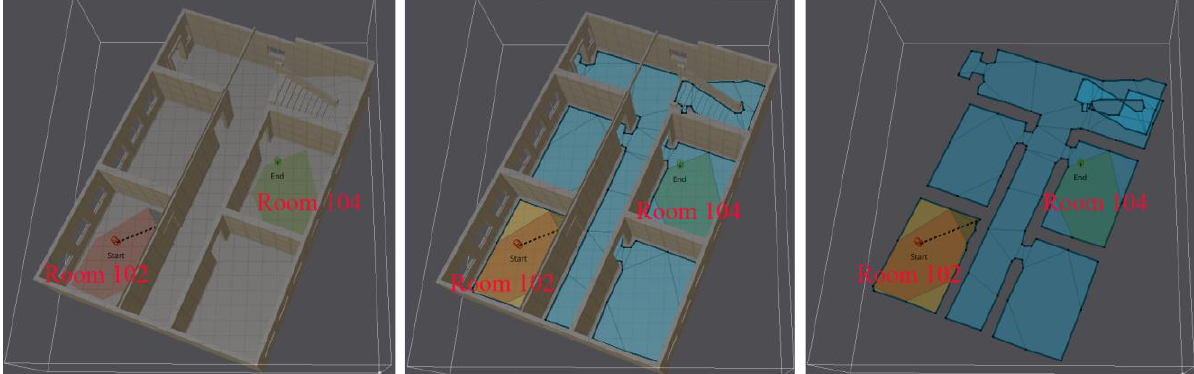
Figure 8 Influence of navigation route by a closed